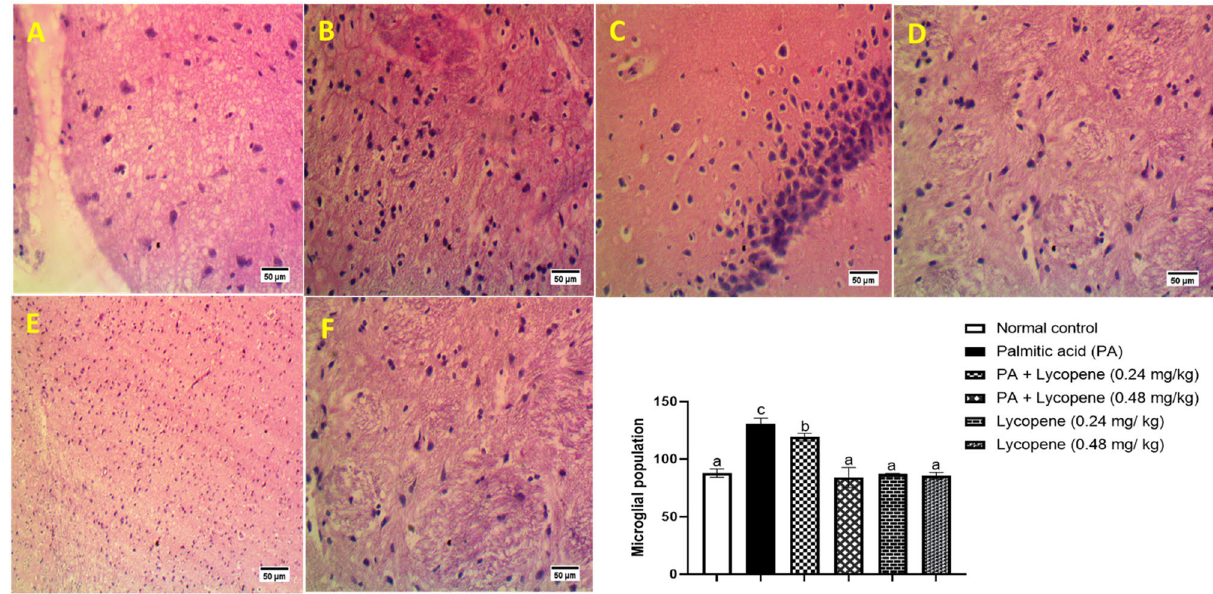
Figure 6. Photomicrograph of rat brain submitted to palmitic acid and treated with lycopene (Hematoxylin and Eosin staining × 400μ; Scale = 50μm). A. Normal control shows moderate vacuolation of the brain tissue (arrowhead). B. Shows PA control with severe vacuolation and a high number of microglia cells population. C. PA + lycopene (0.24 mg/kg) shows normal architecture. D. PA + lycopene (0.48 mg/kg) shows brain tissue with normal architecture (arrow head). E. Lycopene (0.24 mg/kg) group shows normal histology. F. Lycopene (0.48 mg/kg) shows normal